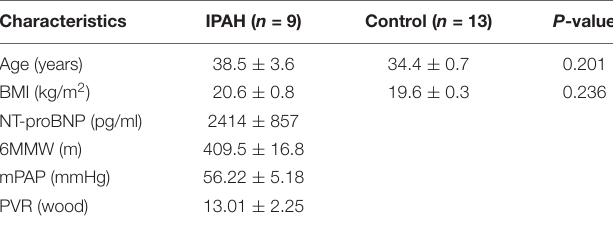
TABLE 4 | Clinical characteristics of the study population.